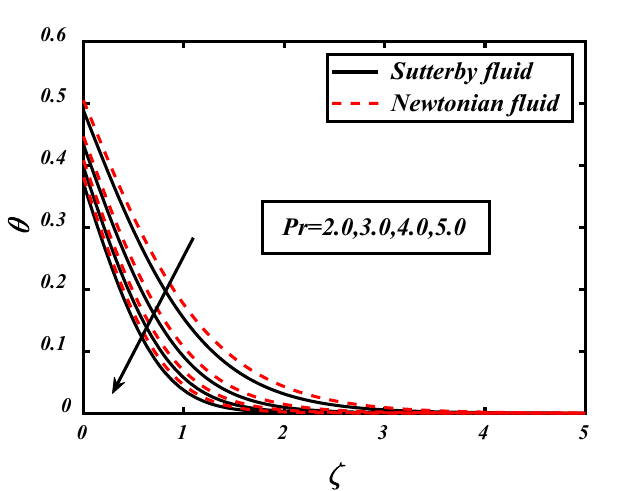
Figure 7. Expounds the impacts of Pr on θ